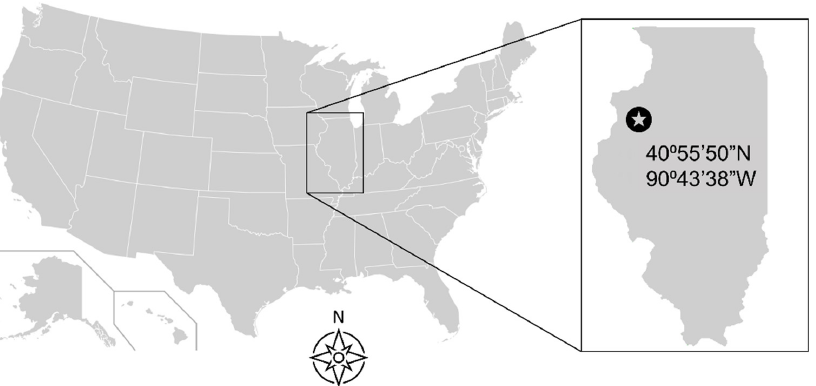
Figure 1. Reference map of the long-term experimental site at Monmouth, Illinois, U.S.A. with its coordinates .